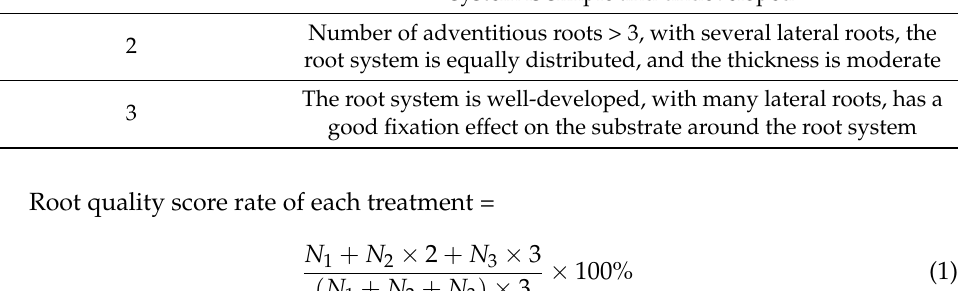
Table 2. Scoring criteria of roots. Score Description of Each Stage Number of adventitious roots ≤ 3, no lateral roots, the root 1 system is simple and undeveloped Number of adventitious roots > 3, with several lateral roots, the 2 root system is equally distributed, and the thickness is moderate The root system is well-developed, with many lateral roots, has 3